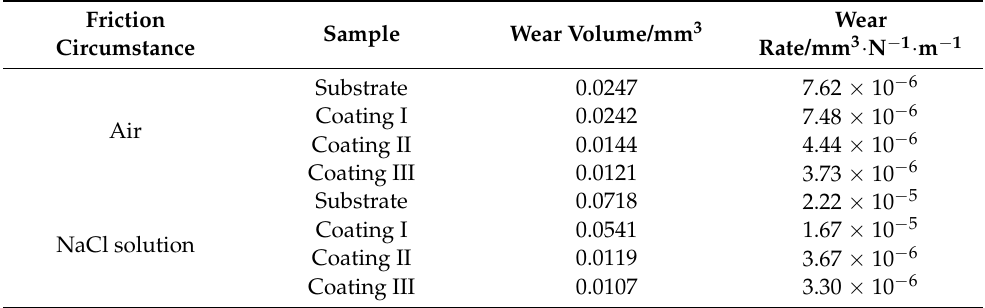
Table 3. Wear volumes and wear rates of the samples subject to friction in air and 3.5 wt.% NaCl solution.